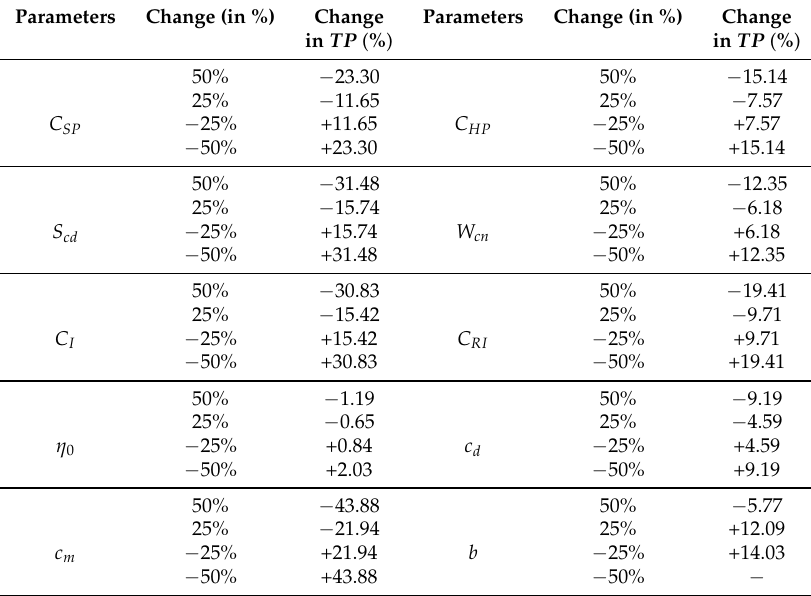
Table 6. Sensitivity analysis